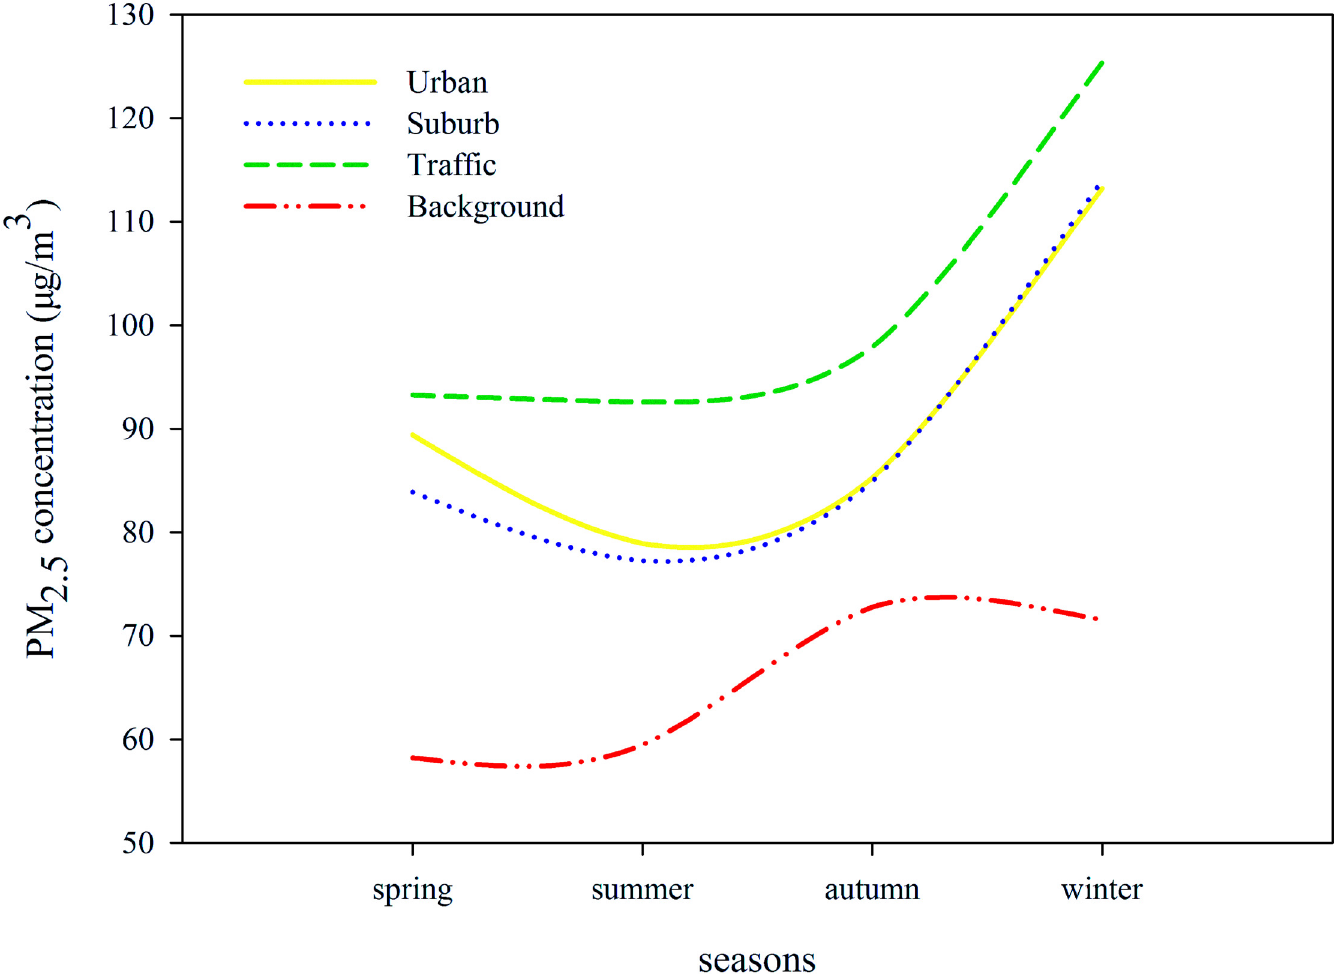
Fig 2. Seasonal pattern of four categories of all